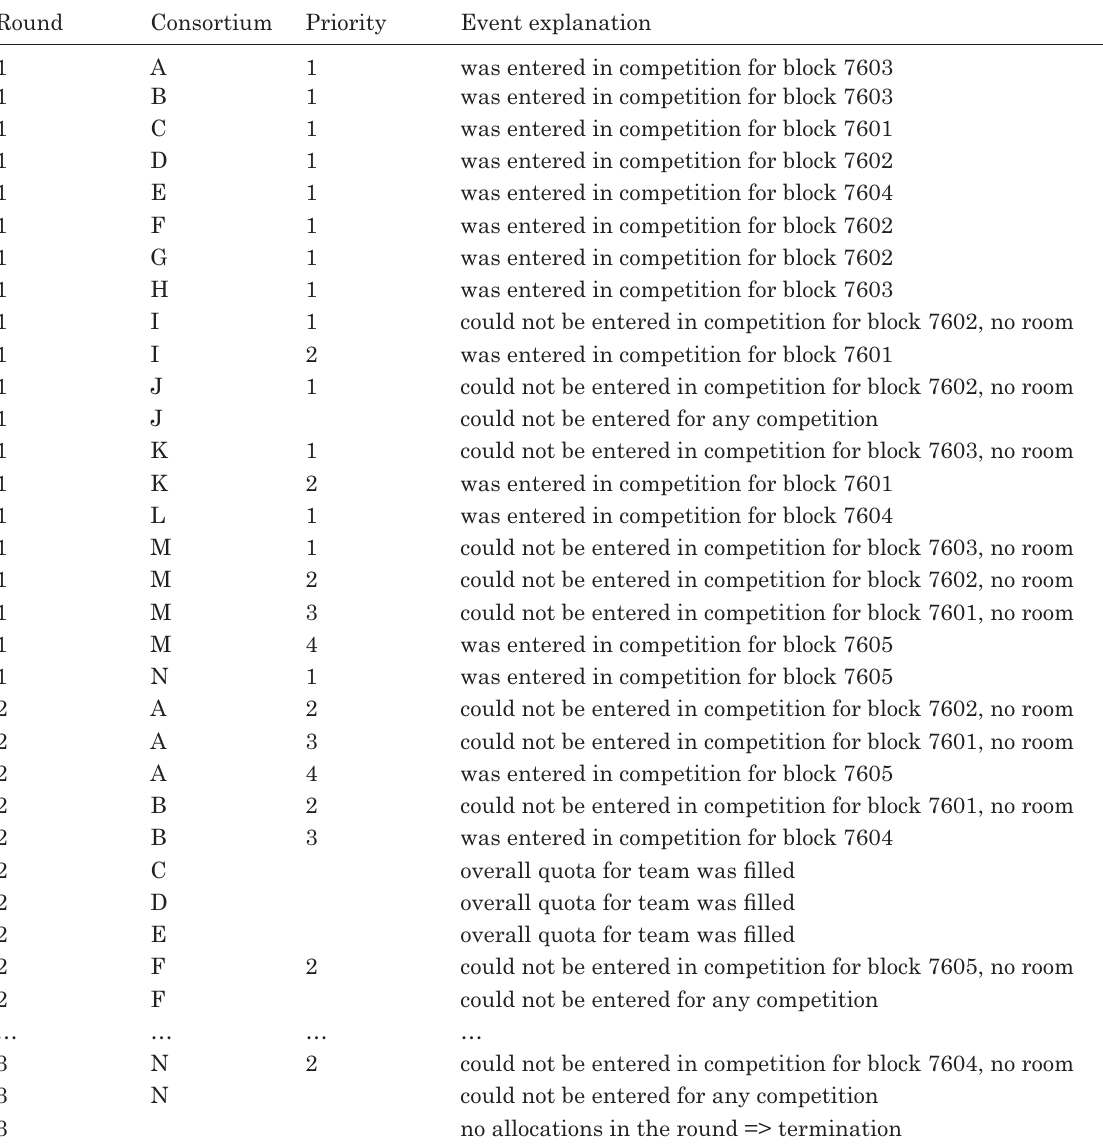
Table 6. Logging of the allocation procedure Round